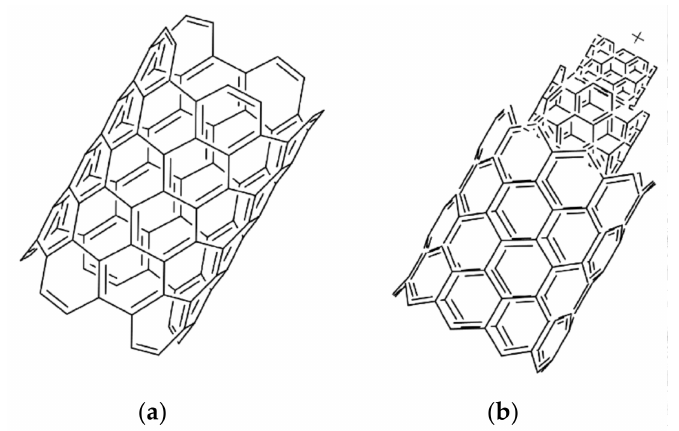
Figure 1. Longitudinal section of ( a ) single-walled carbon nanotube (SWCNT) and ( b ) multiwalled carbon nanotube